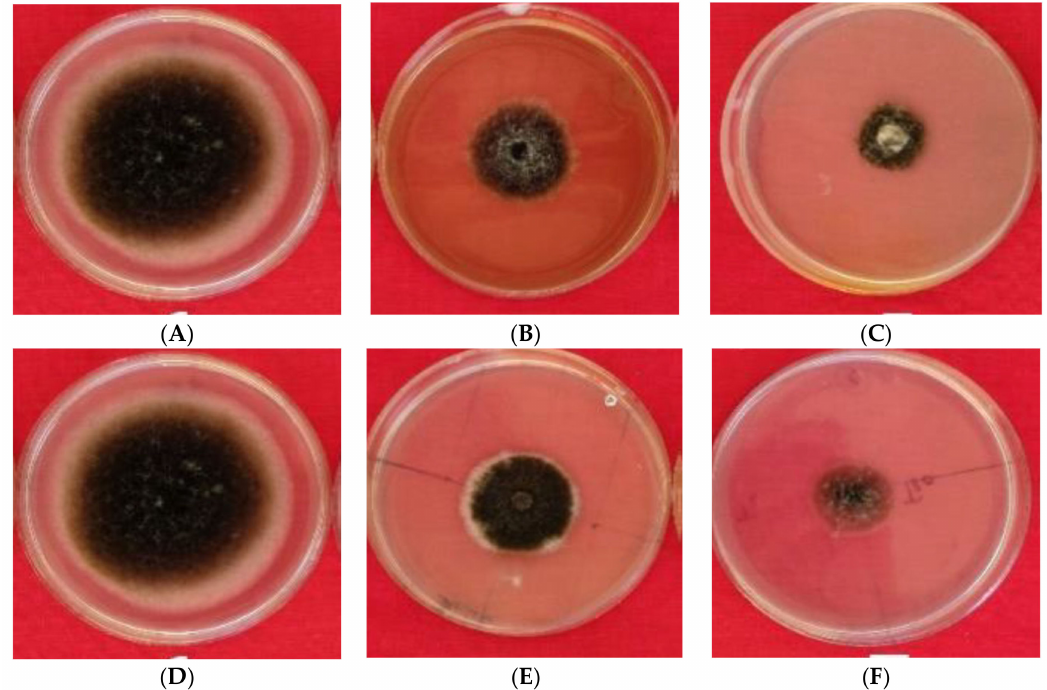
Figure 10. Effect of different fruit peel extracts and their AgNPs on radial growth of A. solani (cm) at the concentration of 100 µ g/mL. Control, medium only ( A , D ), pomegranate peel extract ( B ) and their AgNPs ( C ), orange peel extract ( E ) and their AgNPs ( F ).